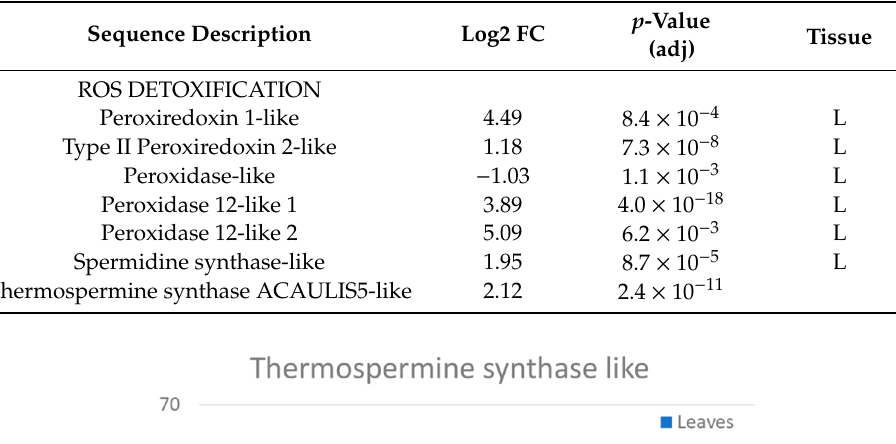
Table 5. Differentially expressed genes related to ROS detoxification in tolerant vs. sensitive plants Tissue column indicates tissue specificity of the tolerant vs. sensitive expression.